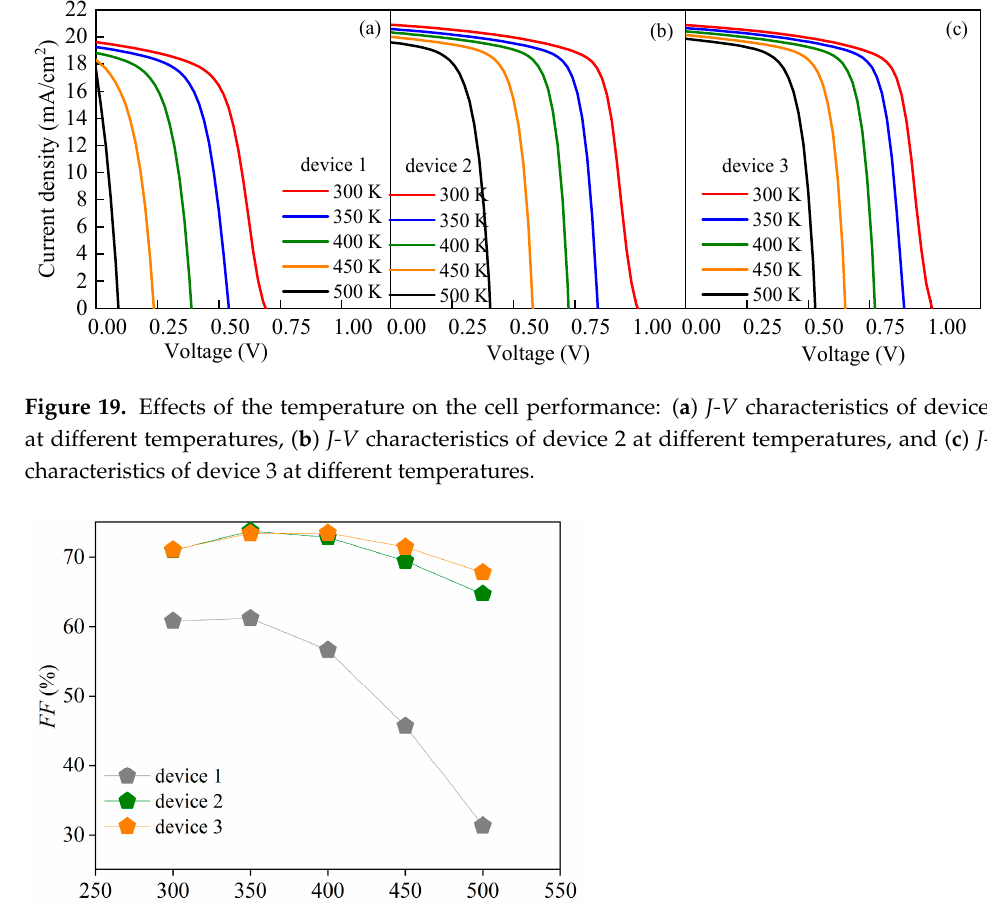
Figure 18. Effects of N it on the interface recombination: ( a ) effect of N it on the interface recombination of device 1, ( b ) effect of N it on the interface recombination of device 2 and ( c ) effect of N it on the interface recombination of device 3.